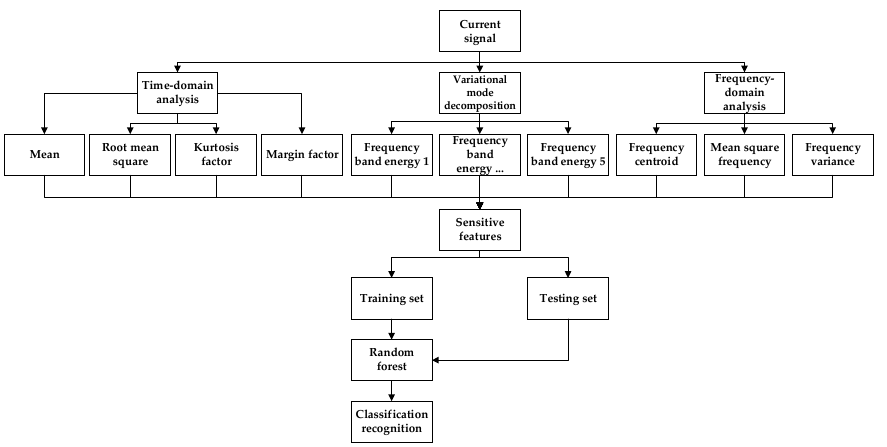
Figure 8. Tool wear condition recognition roadmap based on current signal